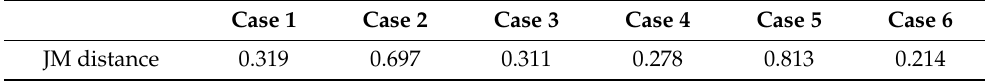
Table 5. The JM distance values for the six domain adaptation cases.